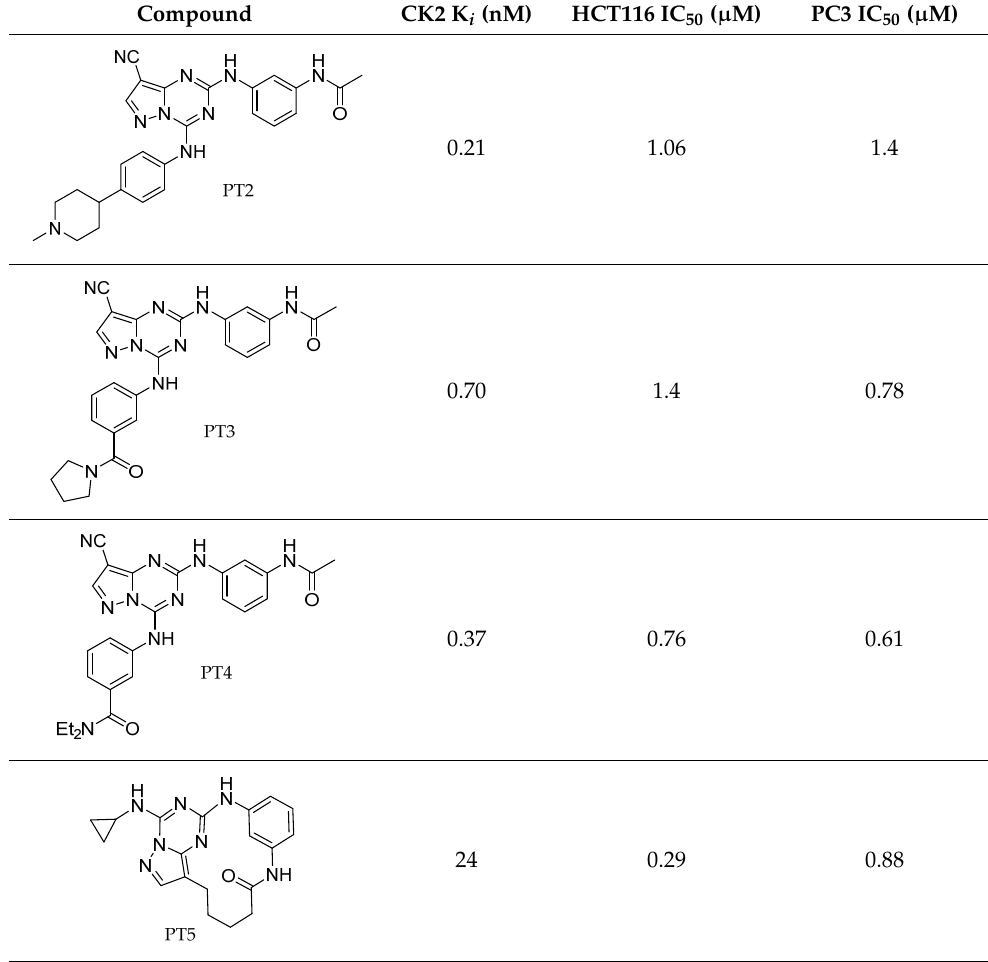
Scheme 5. Synthetic route to the pyrazolo-triazine ATP-competitive CK2 inhibitor PT1. ( a )